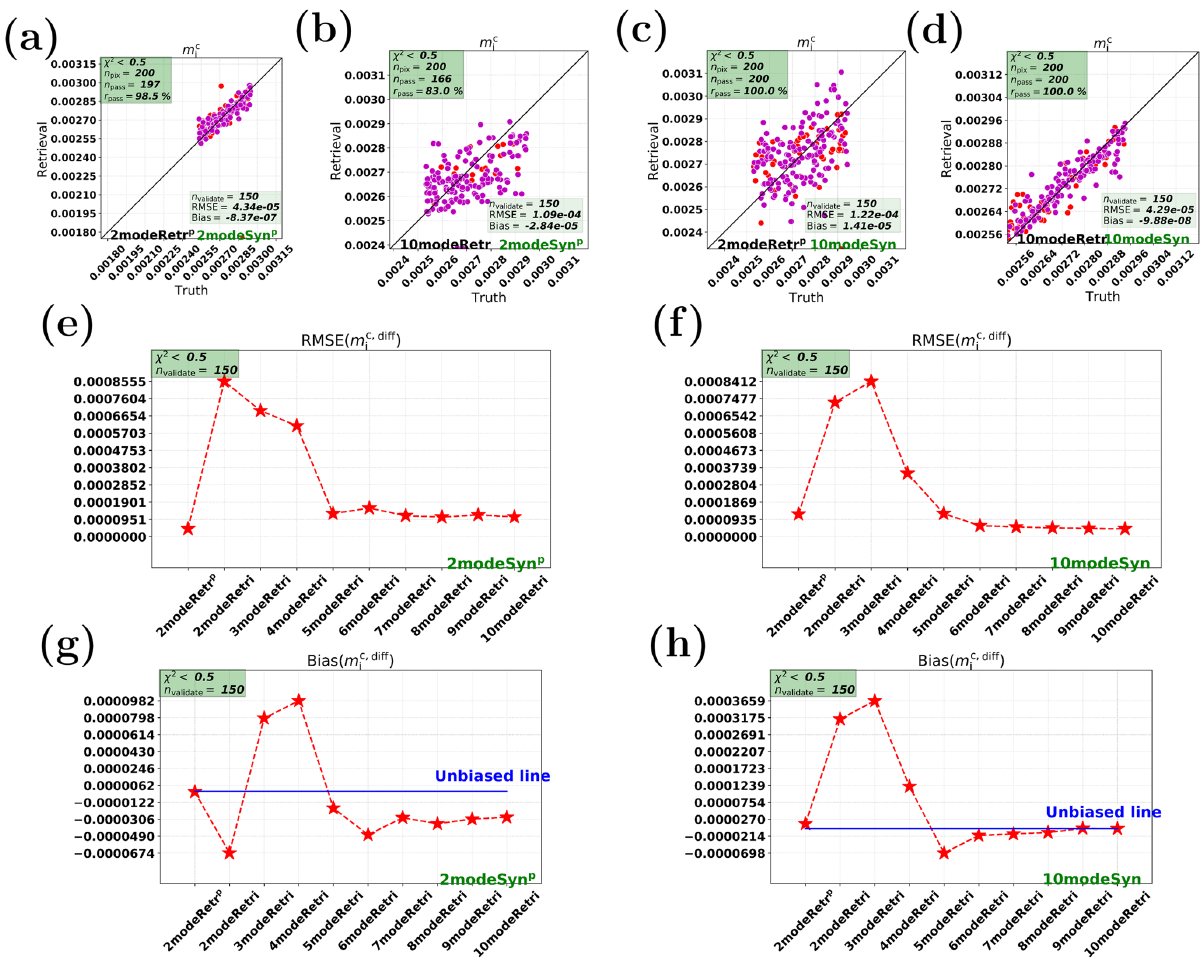
Figure 10. Synthetic retrievals for the imaginary part of refractive index (at 550nm) of the coarse modes ( m c f, h) show cases on 2modeSyn p and 10modeSyn,